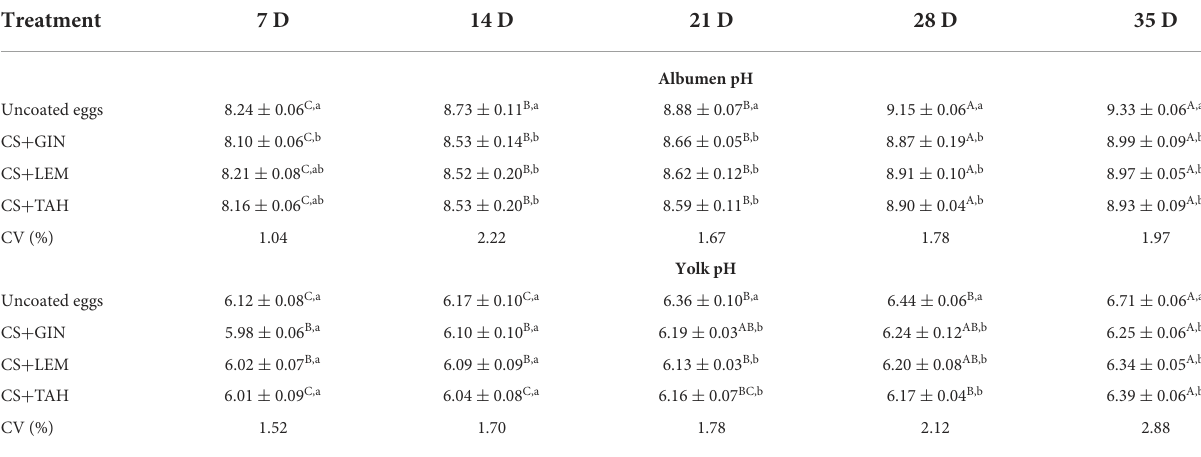
TABLE 3 Albumen and yolk pH of the different treatments during the 35 days of storage at 20 ◦ C.